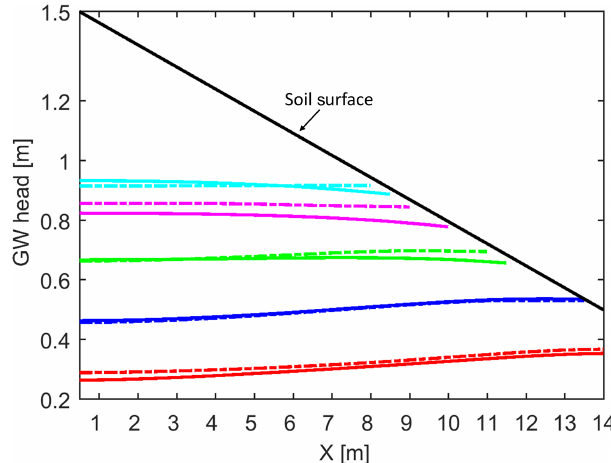
Figure 8. Simulated water table level after 4 (red), 8 (blue), 12 (green), 16 (magenta), and 20 days (sky blue) with MIKE SHE (solid lines) and MOBIDIC–MODFLOW (dashed